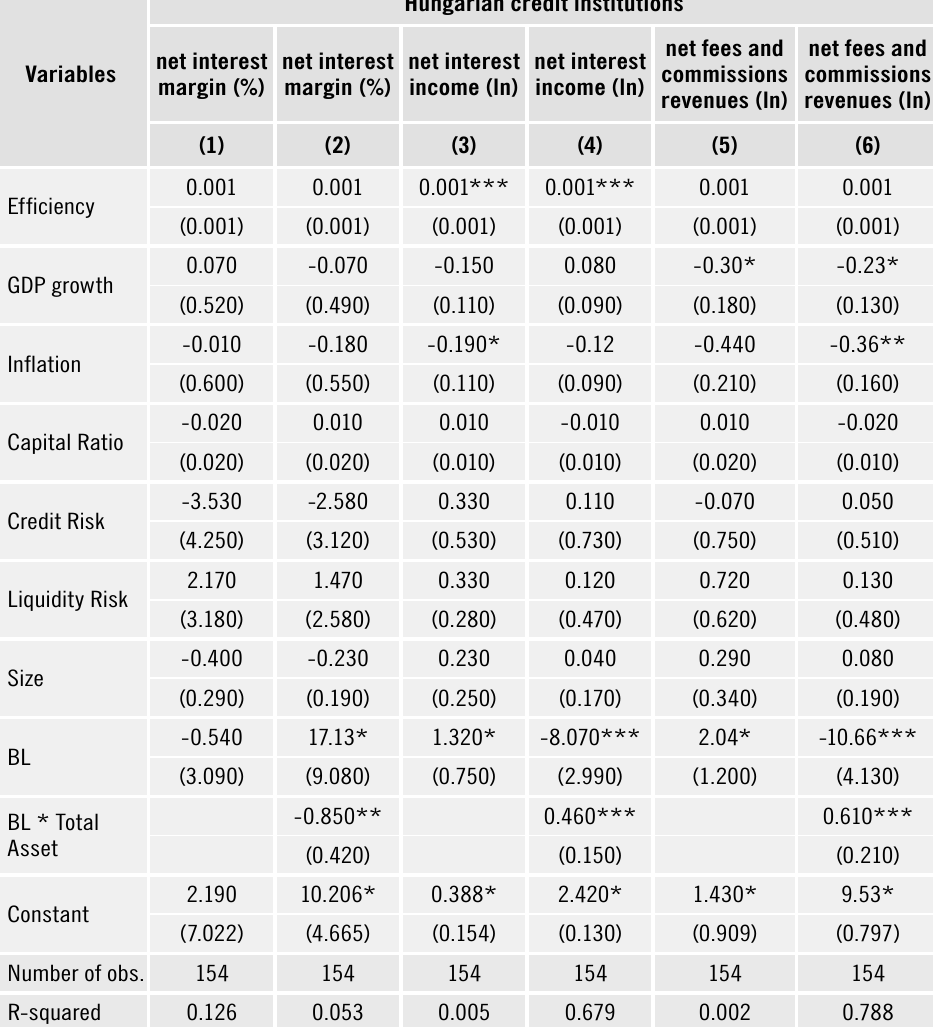
Table 7. Data presenting estimates based on GLS regressions with a random effect on Hungarian credit institutions in 2008-2015. Data have been sourced from unconsolidated financial statements. Institution-specific characteristics appear as one-year lagged variables in all specifications. The bank levy (BL) is represented by a dummy variable indicating 1 for all years the levy applies to, and zero for all remaining years. Robust standard errors that control for clustering at the financial institution level are reported in